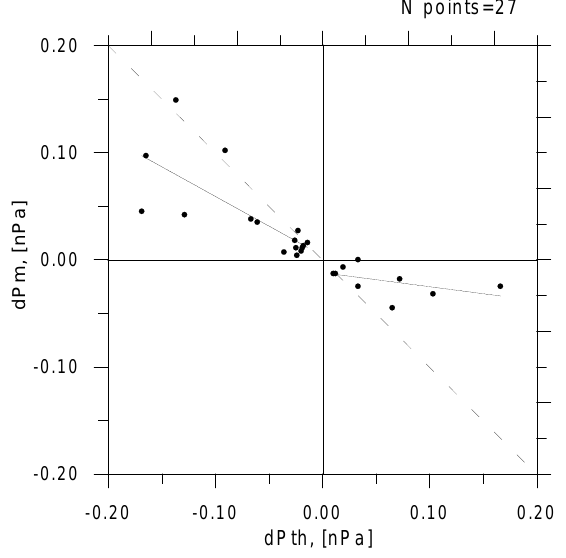
Fig. 8. Relation between magnetic field pressure and thermal pres- sure changes during the largest dynamic pressure fronts. The dash line shows the equality of changes, solid lines show the best fit ap-